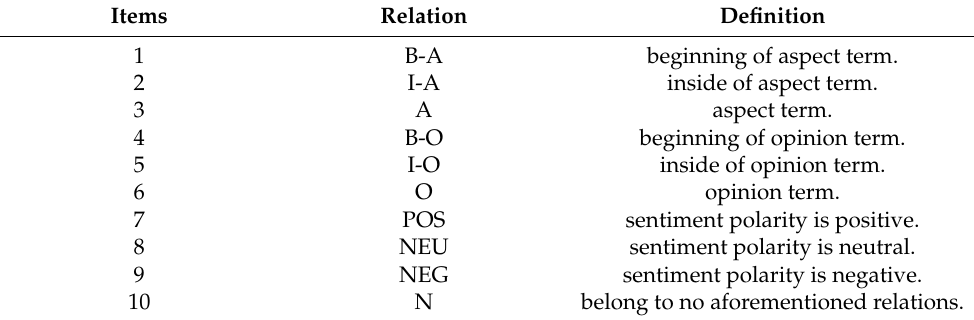
Table 1. The definitions of our defined